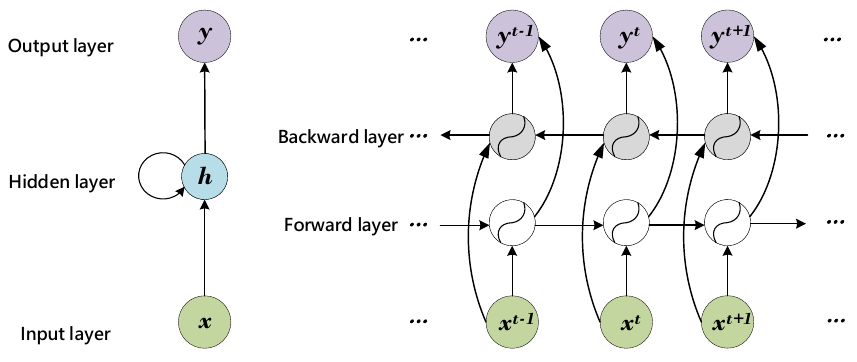
Figure 2. The left part is a brief illustration of RNN, and the right part shows the unfold bidirectional RNN (Bi-RNN) structure.